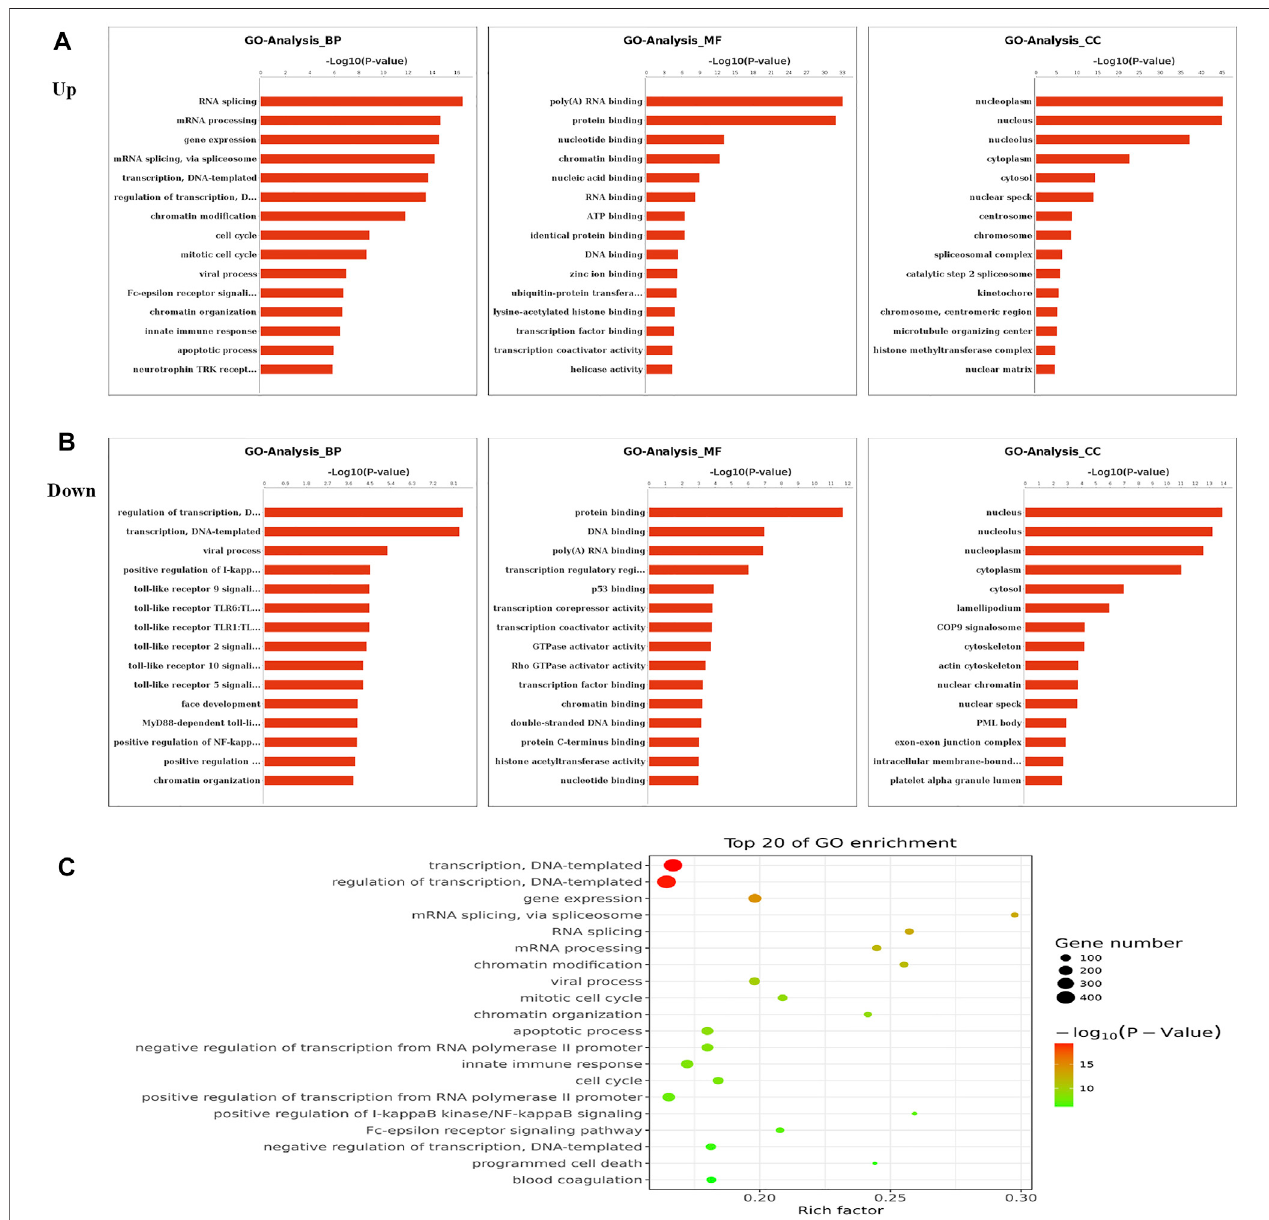
FIGURE 2 | Gene ontology and Enrichment analysis of differential m 6 Apeaks. (A) The top ten Gene Ontology terms related to mRNAs with increased methylation; terms in the biological process (BP), molecular function (MF), and cellular component (CC) categories are shown; ( − log10p) for signi fi cance. The log-transformed results were used for visualization. (B) The top ten Gene Ontology terms related to mRNAs with decreased methylation, terms in the BP, MF and CC categories are shown; ( − log10p)forsigni fi cance.Thelog-transformedresultswereusedforvisualization. (C) TheGObubbleshowsthetop20GeneOntologytermscorrespondingtothe methylated